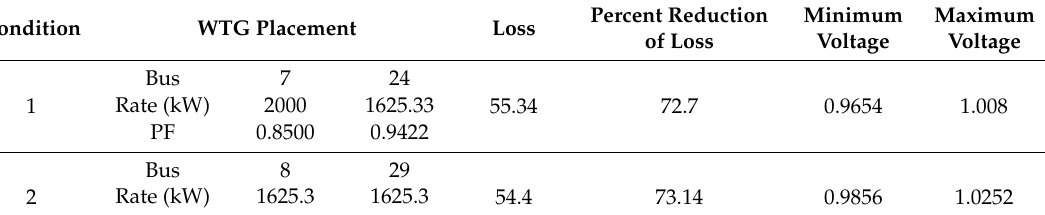
Table 6. Results of site selection for 32-bus grid with respect to constraints.